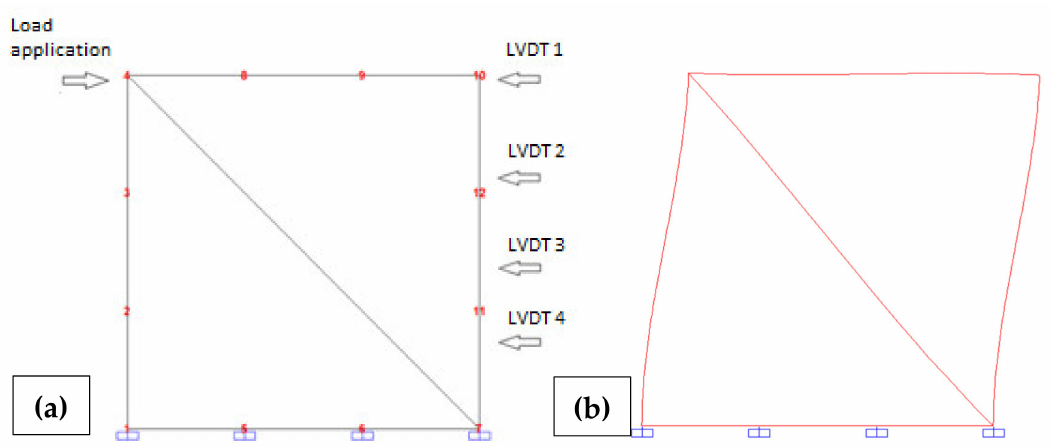
Figure 17. ( a ) Panel model used to calibrate the diagonal bar; ( b ) Deformed shape of the panel used for the diagonal bar’s calibration